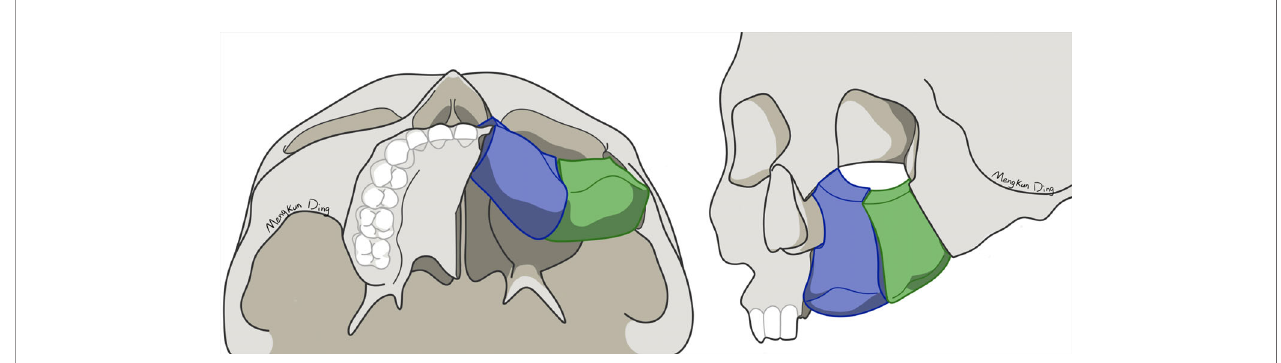
FIGURE 5 | Shaping and reconstruction strategy for Brown class